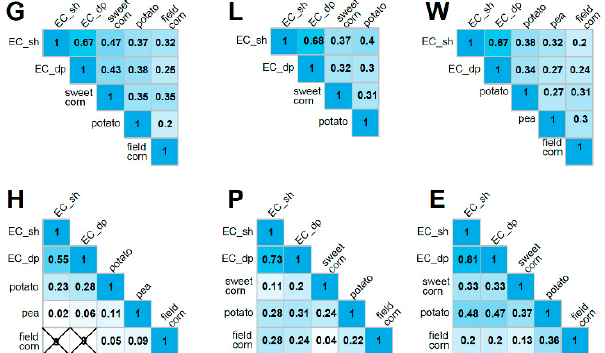
Figure 9. Kendall’s tau correlation coefficient matrices for fields H, G, P, L, E, and W Correlations are for the following parameters: shallow and deep apparent electrical conductivity (EC_sh and EC_dp, respectively) and relative evapotranspiration for each crop rotation (‘sweet corn’, ‘potato’, ‘pea’, and ‘field corn’). Correlations are all statistically significant at an alpha level of 0.001 unless they are crossed out with ‘X’ symbols.